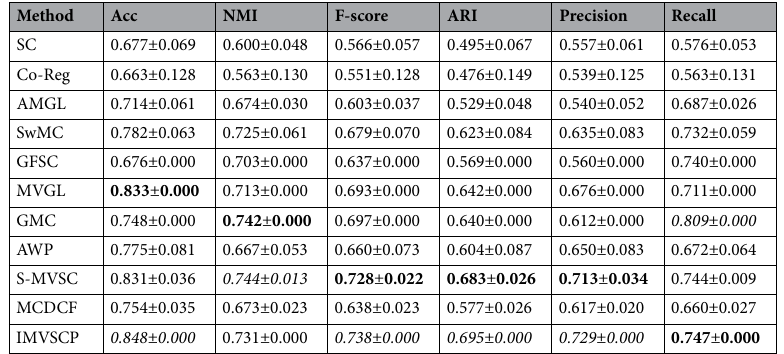
Table 4. Experimental results (mean standard deviation) on the MSRC dataset. Significant values are in [bold/ italics].